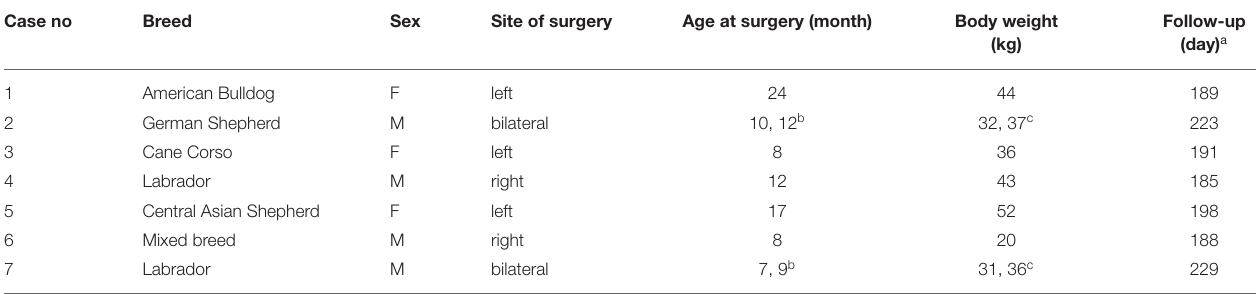
TABLE 1 | Summary statistics for breeds, sex, site of surgery, age at surgery (month), body weight (kg), follow-up (day). Case no Breed Sex Site of surgery Age at surgery (month) Body weight